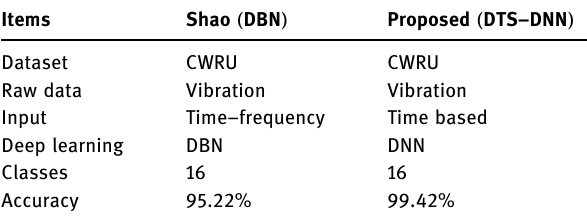
Figure 15: Comparison with shallow